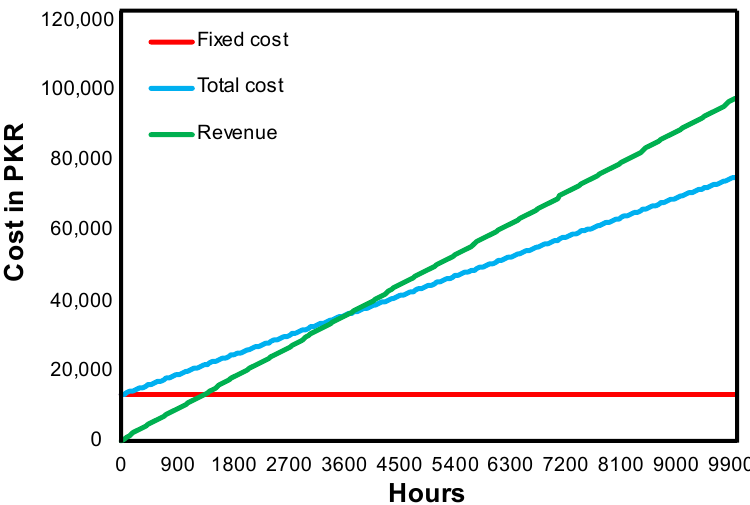
Figure 13. Breakeven analysis of the solar air heater.